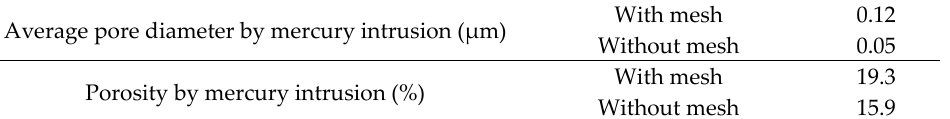
Figure 5. Porosimetry properties obtained by mercury intrusion of cement mortar applied to hollow ceramic brick substrate, with and without mesh.